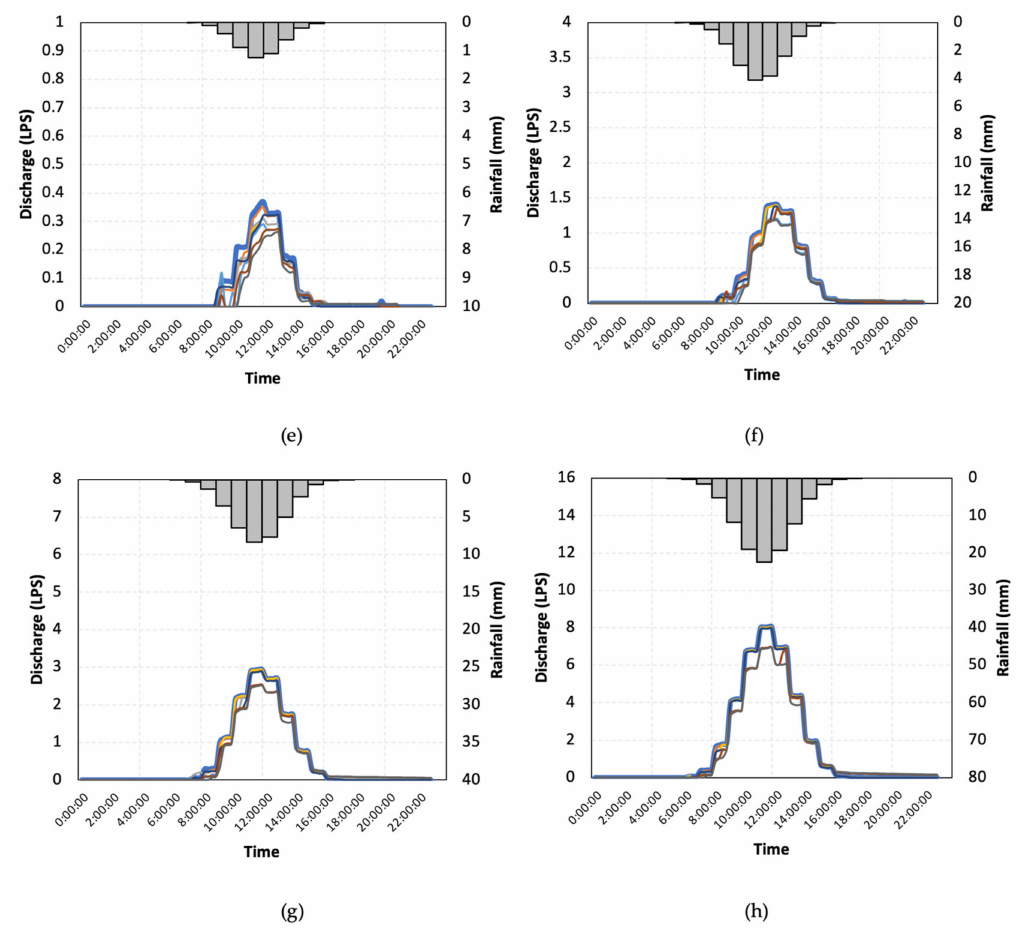
Figure 7. Hydrographs of the optimal scenarios in the ( a ) 80th, ( b ) 90th, ( c ) 95th, and ( d ) 99th percentiles for the optimistic estimate and ( e ) 80th, ( f ) 90th, ( g ) 95th, and ( h ) 99th percentiles for the pessimistic